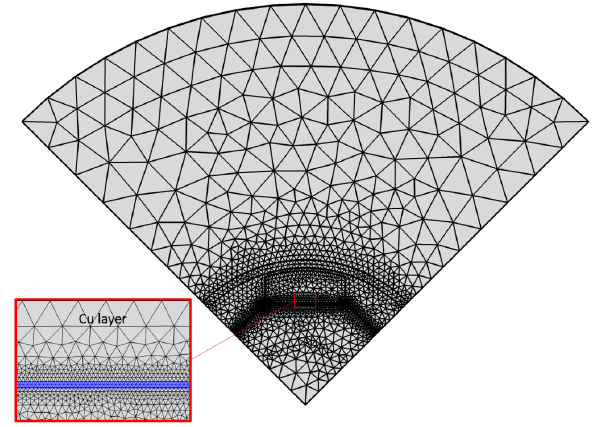
FIG. 6. Domain discretization of the Q1 beam screen including the air box. A magnification of the Cu layer is shown in the box on the